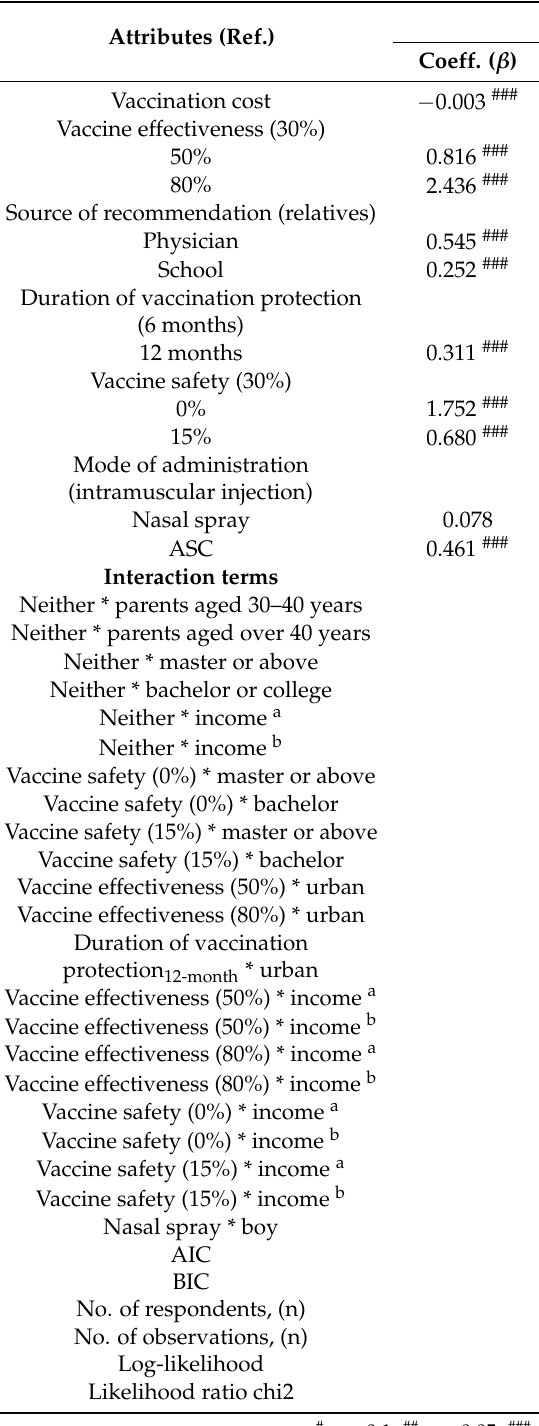
Table 3. Results of mixed logit model with main effects and interactions in all